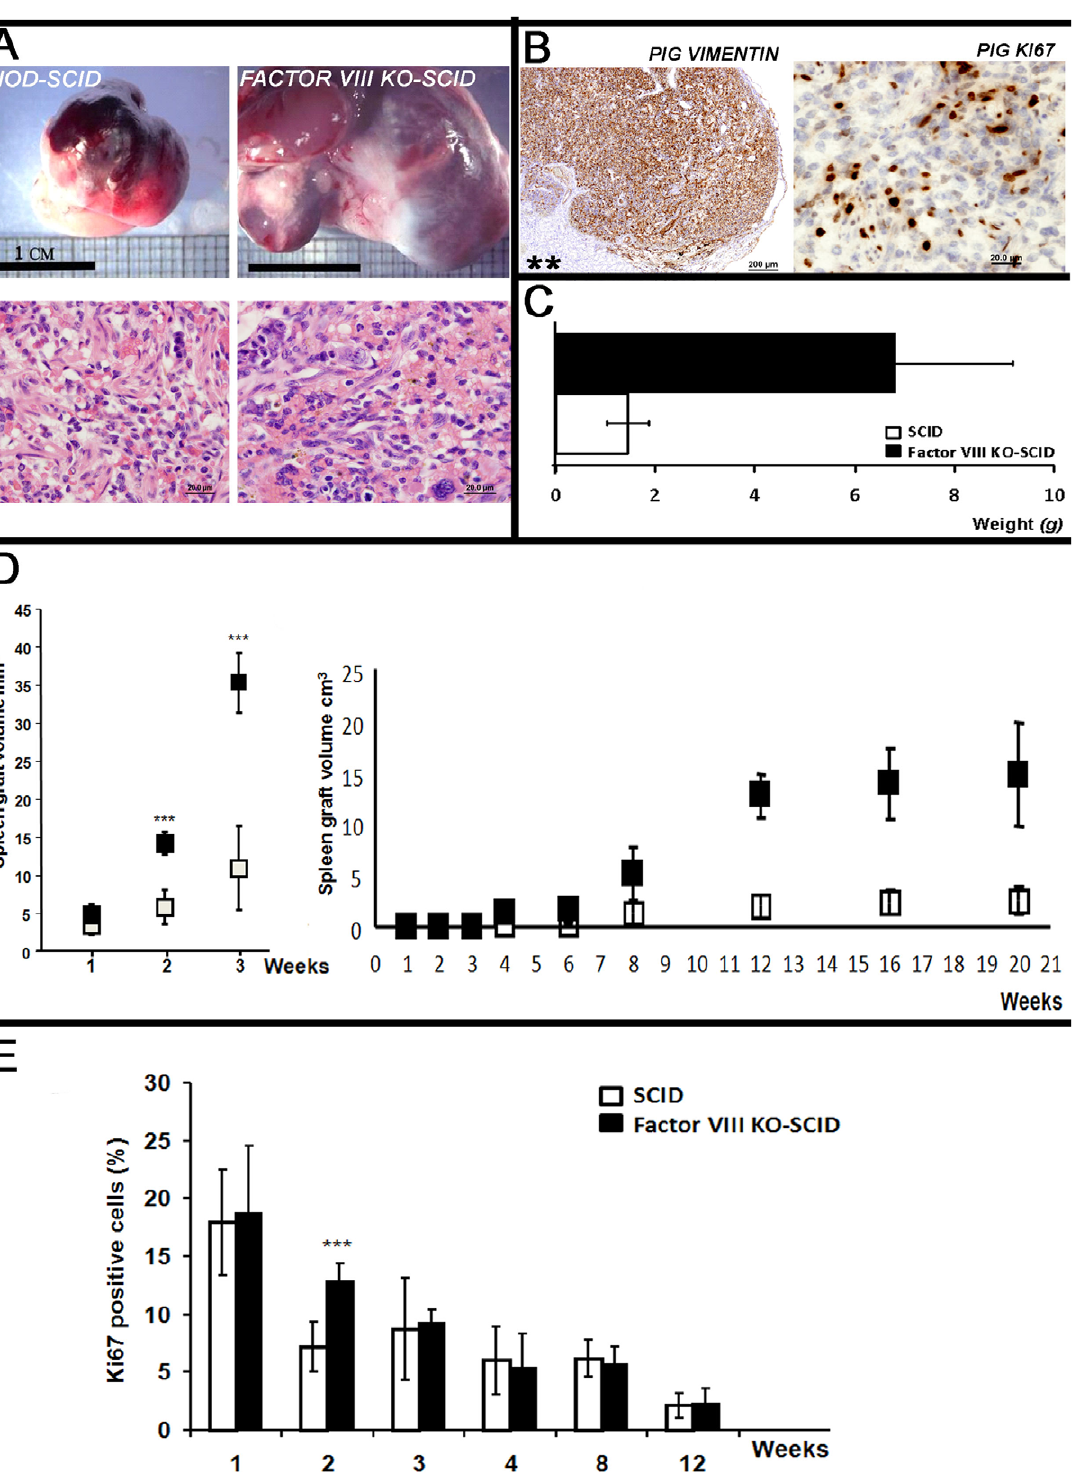
Figure 1. Growth enhancemnt of E42 embryonic spleen implants in Factor VIII KO-SCID mice. (A) Upper panel: Macroscopic view at 3 months post transplant of E-42 spleen grafts implanted into NOD-SCID or Factor VIII KO SCID recipients. Lower panel: Representative H&E staining revealing similar morphological patterns in NOD-SCID (left) and in Factor VIII KO SCID (right) mice. (B) Pig mesenchymal components stained with anti-vimentin (V9) and proliferating pig cells stained with anti-ki67 within the implant growing in Factor VIII KO recipients are shown in brown. Asterisk points to mouse kidney not stained by these pig specific antibodies. (C) Average weight of E42 spleen grafts at 3 months post transplant in the two types of recipients, (n=20). (D) Graft volume of the implants in the two recipient groups during the first 3 weeks post transplant and over a 5 months follow-up period. (E) Percentage of dividing ki67 positive cells per square mm in the growing implants.